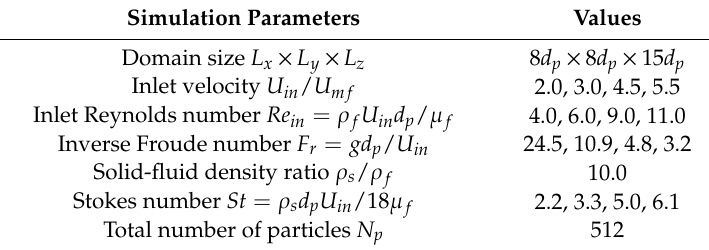
Table 1. Simulation parameters of liquid–solid fluidized